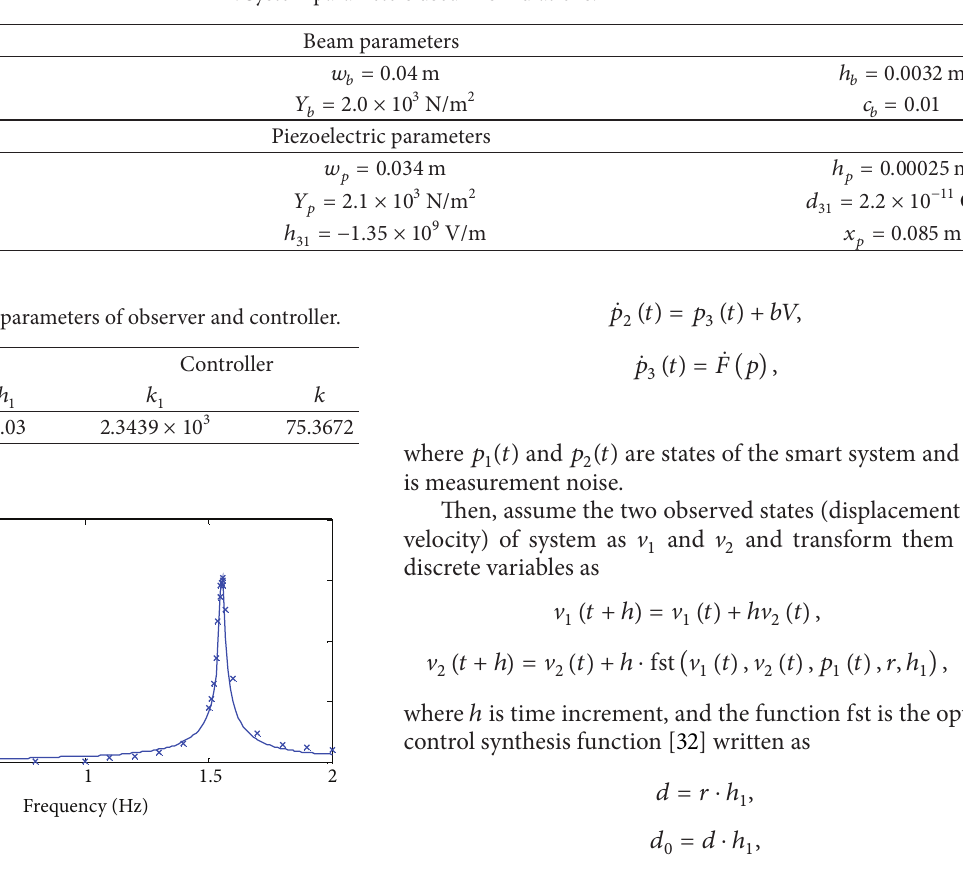
Table 1: System parameters used in simulations.